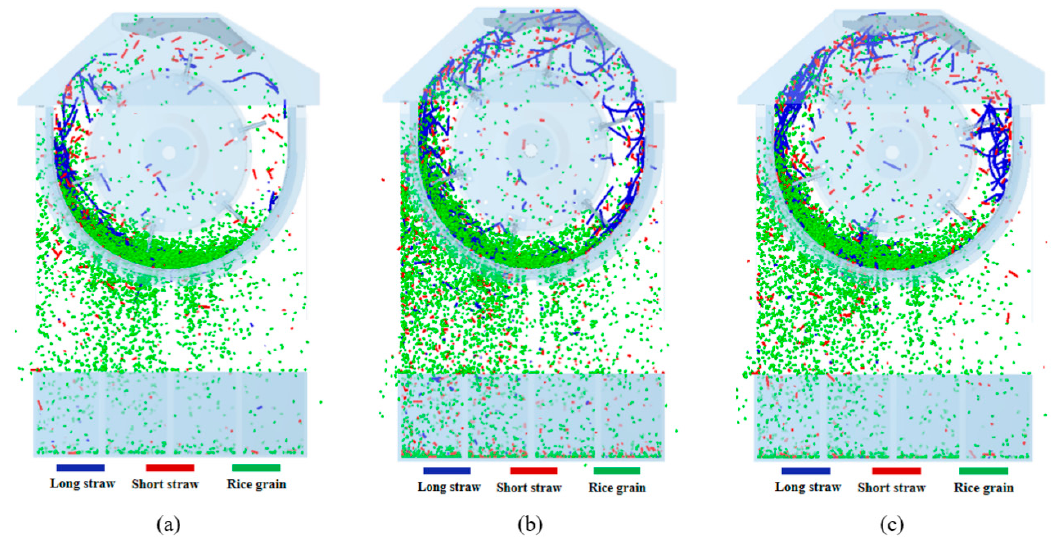
Figure 7. Circumferential distribution of rice mixture in the concentric threshing device at 0.5 s: ( a ) single threshing gap of 15 mm; ( b ) single threshing gap of 10 mm; ( c ) multi-threshing gaps of 10 mm and 15 mm.